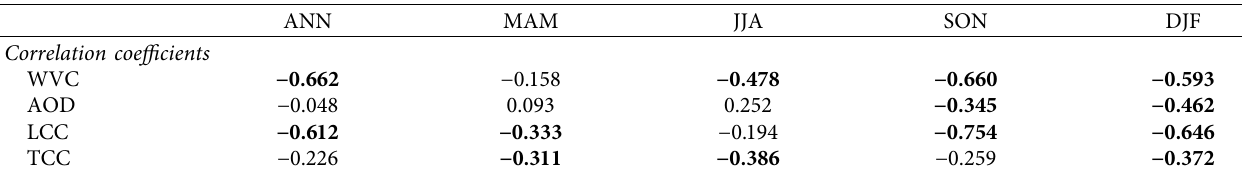
Table 2: Annual mean daily values of E